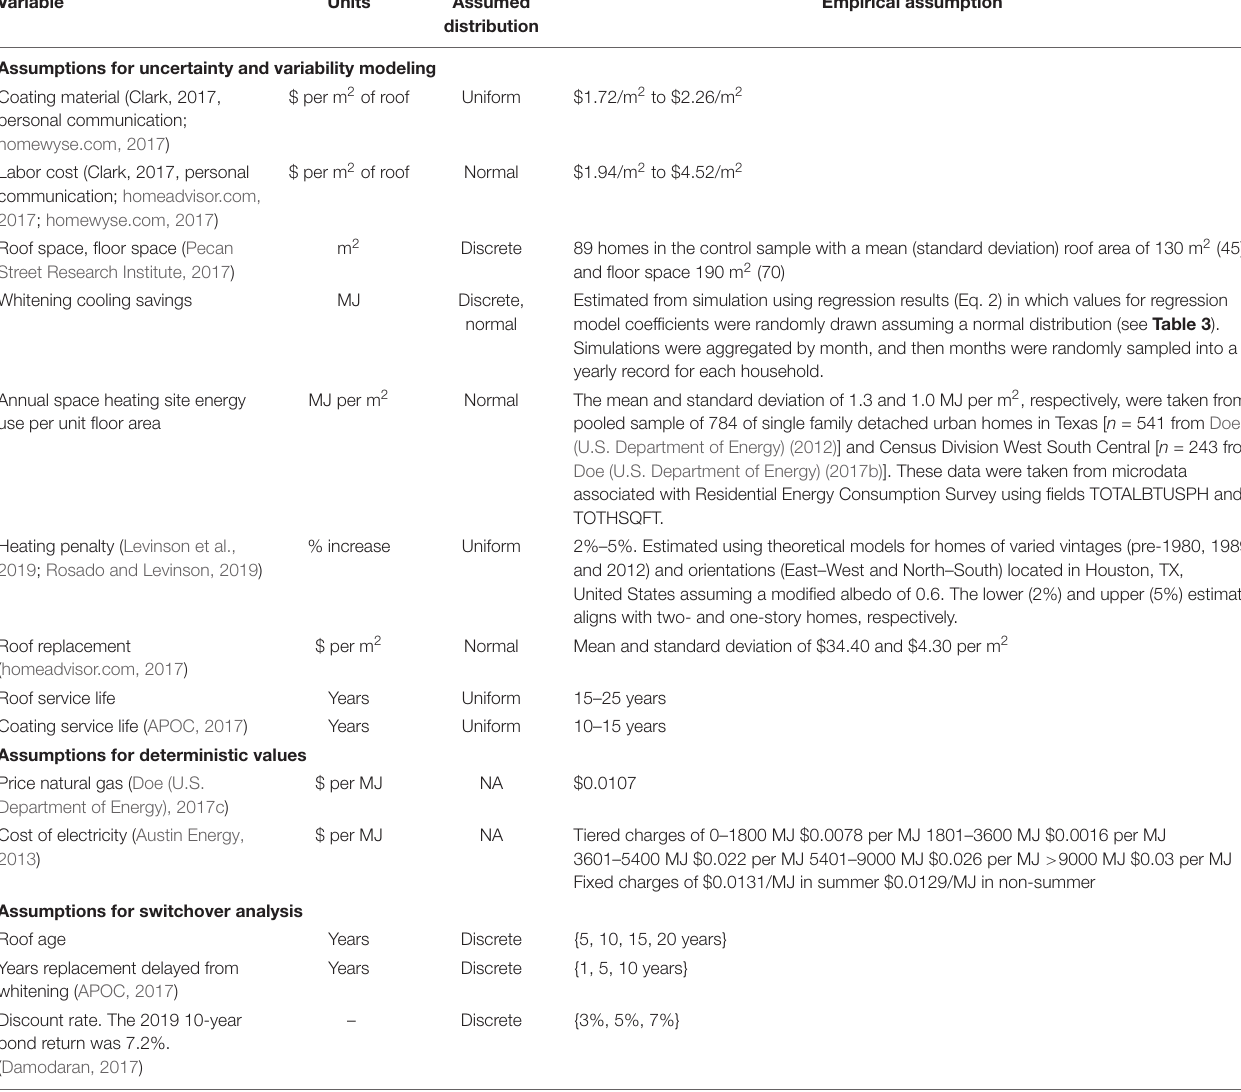
TABLE 2 | Assumptions used for the cost analysis.